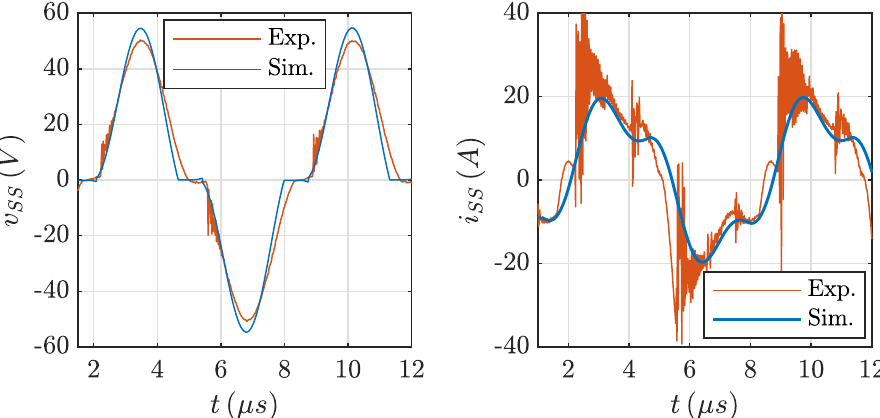
Figure 7. Waveforms of the voltage v SS ( t ) and the current i SS ( t ) measured at the bridge rectifier input